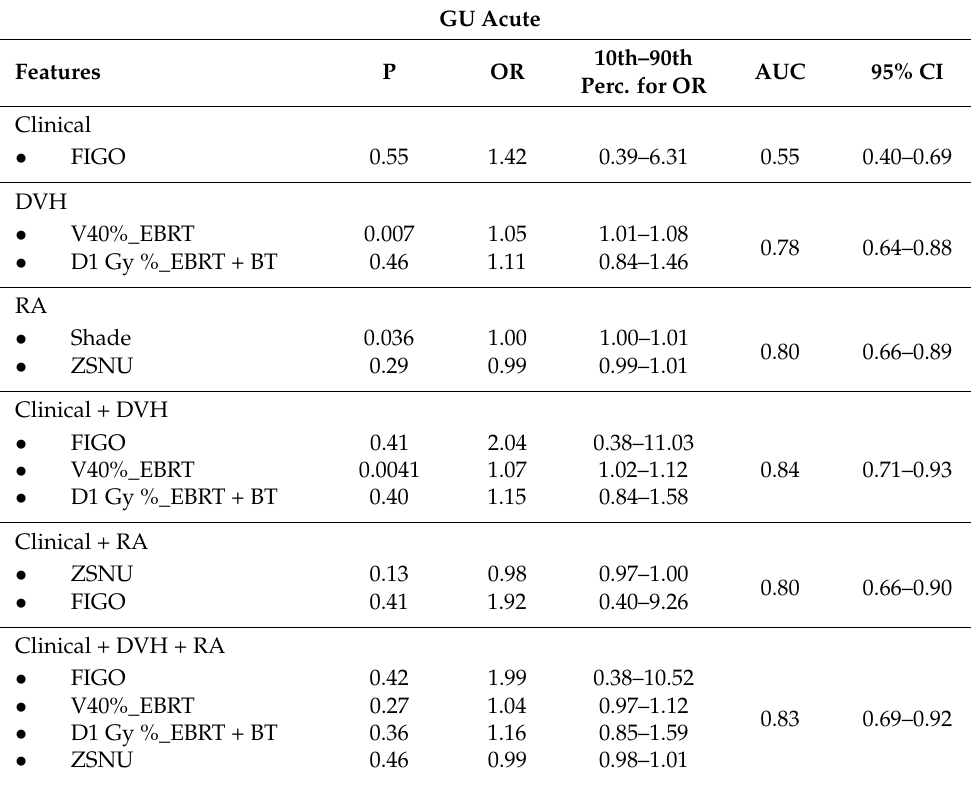
Table 2. Results of the multivariate logistic analysis for acute genitourinary